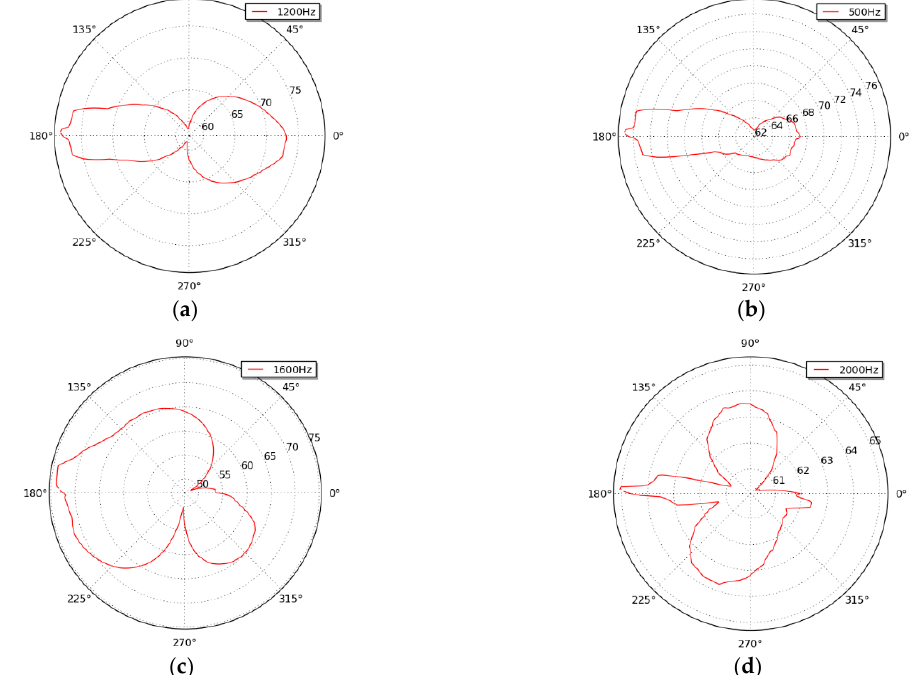
Figure 16. Horizontal directivity of sound pressure of the sail hull in the high-frequency range: ( a ) f = 500 Hz; ( b ) f = 1200 Hz; ( c ) f = 1600 Hz; and ( d ) f = 2000 Hz.